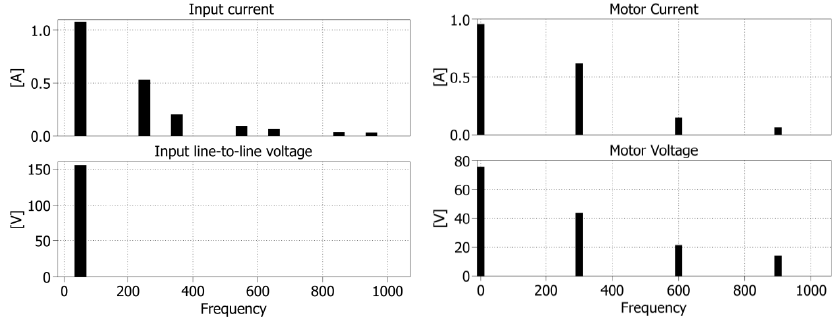
Figure 7. Simulation results for the firing angle of the rectifier’s thyristors equal to 60°.